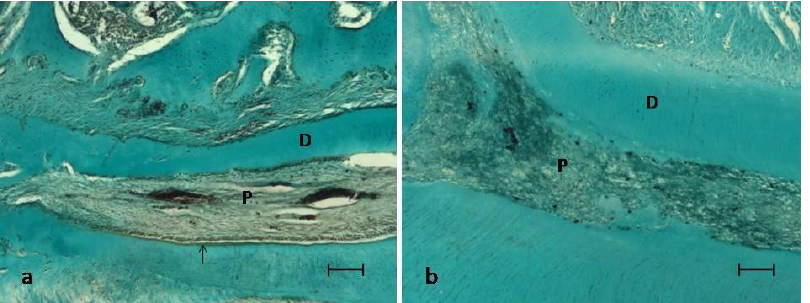
Figure 1. Images of the pulp exposure site of two experimental groups at thirty days post-treatment. ( a ) MTA group. ( b ) HA/β-TCP/C group. Both groups showed a well-developed dentinal bridge (db) formed in contact with the material (asterisk) used for pulp capping. P = viable pulp without necrosis; D = dentin. Hematoxylin and eosin staining. Scale bar: 100 micrometers.